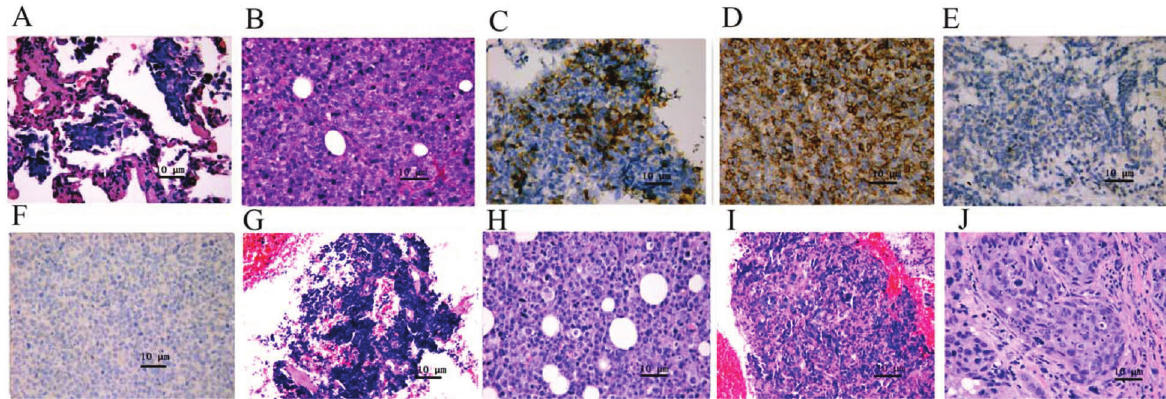
Figure 2. Histology of the primary tumors of patients and patient-derived tumor xenograft (PDTX) tumors. Microphotographs of H&E staining of 010000 in a patient show that the primary tumor ( A ) and PDTX tumor ( B ) exhibited the same cell morphologies. Both the primary tumor ( C ) and PDTX tumor ( D ) were positive for CD56 staining and negative for TTF1 staining ( E and F ). Microphotographs of the H&E staining (magni fi cation, (cid:1) 40) of 010026 in a patient shows that the primary tumor ( G ) and PDTX tumor ( H ) exhibited the same cell morphologies. Microphotographs of the H&E staining of 010027 in a patient show that the primary tumor ( I ) and PDTX tumor ( J ) exhibited the same cell morphologies.